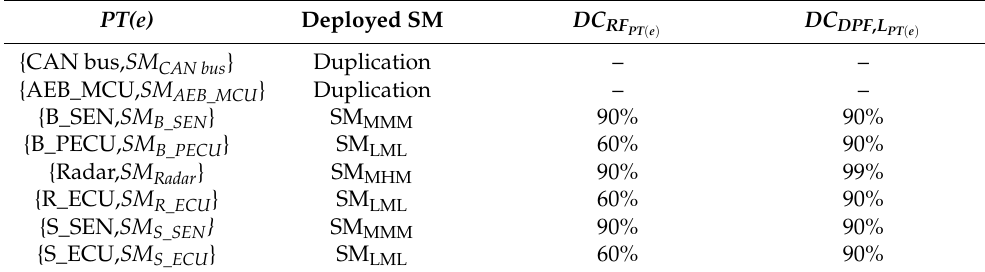
Table 13. Safety mechanism deployments and their DC RF and DC DPF,L for PT .